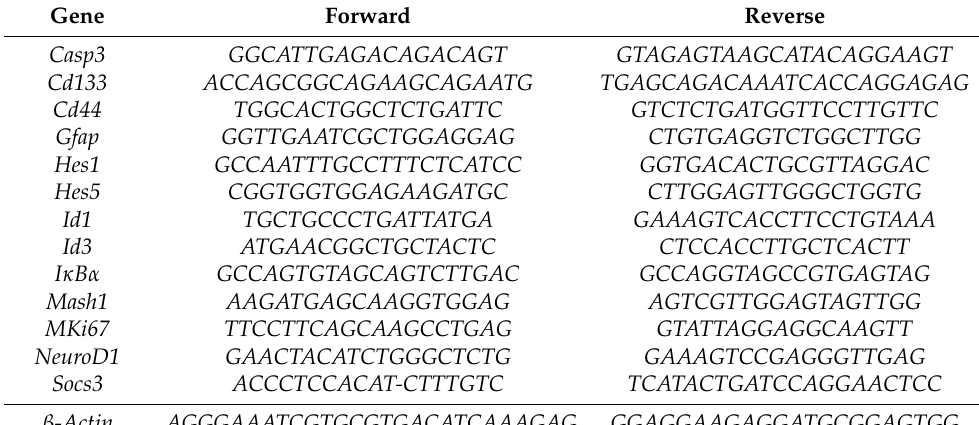
Table 1. List of primer